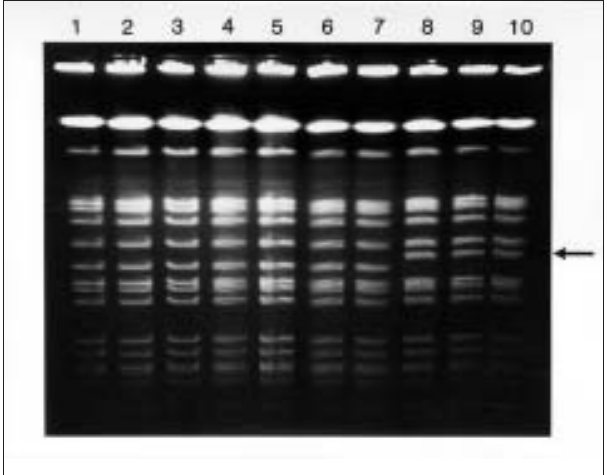
Figure 1) Pulsed-fieldgelelectrophoresispatternof Xba1 digestsofge- nomic DNA from Salmonella tilene isolates. Lanes 1 to 10: 22/77 (Washington State isolate), 44950, 44951, 44952, 93116,